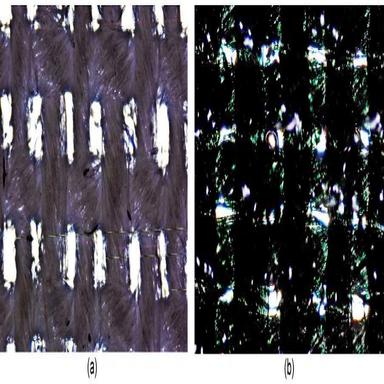
Digital Microscopic image of (a) untreated Cotton fabric and (b) PANI-deposited cotton fabric.